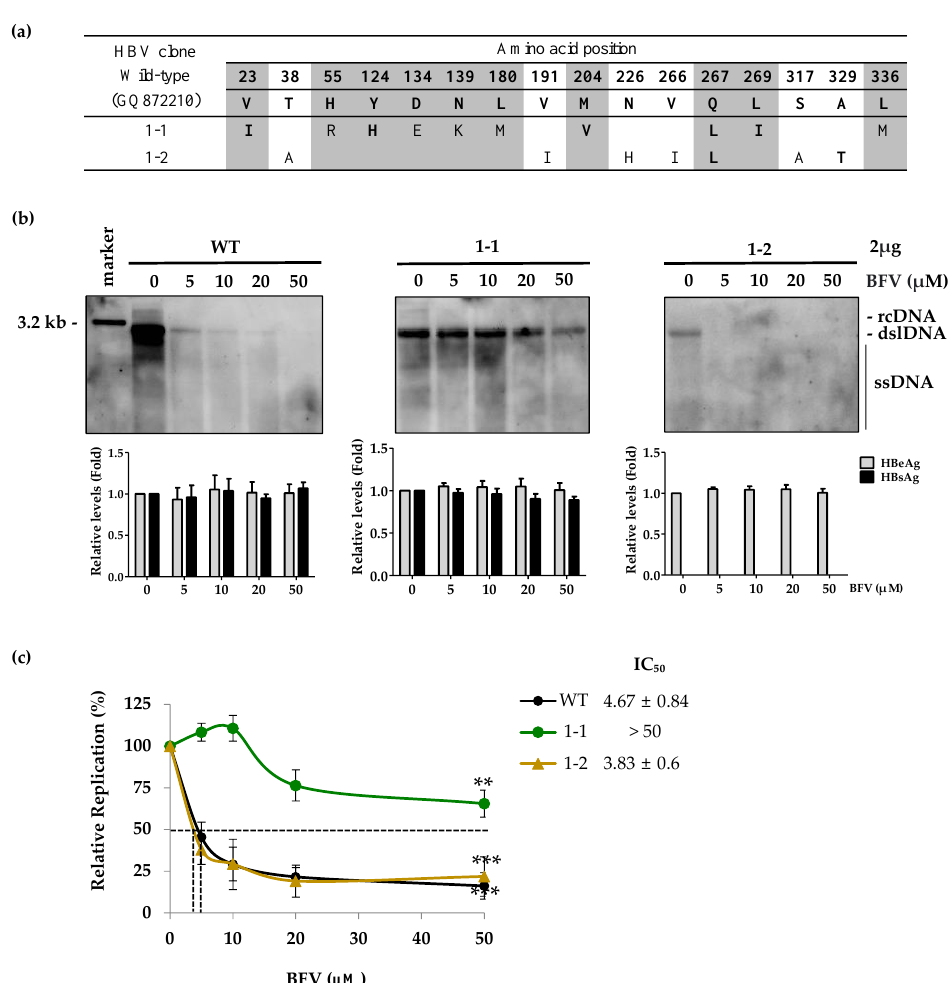
Figure 2. BFV susceptibility of the HBV RT mutants isolated from the CHB patient. ( a ) The amino acid sequences of HBV RT domains isolated from the CHB patient were analyzed by cloning and sequencing. ( b ) The HBV 1.2 mers cloned using the patient-derived RT domain were transfected into the Huh7 cells. HBV DNA and antigen levels were measured by Southern blot and ELISA, respectively. The sensitivity of Huh7 to BFV was determined by southern blot using an HBV- specific digoxigenin (DIG) labeled probe. The 3.2 kb marker is shown in lane 1 ( c ) IC 50 values were determined by quantitative real-time PCR. ** p < 0.01; *** p < 0.001. Data were obtained from at least three independent experiments (mean ± SD). RT, reverse transcriptase; WT, wild type; BFV,